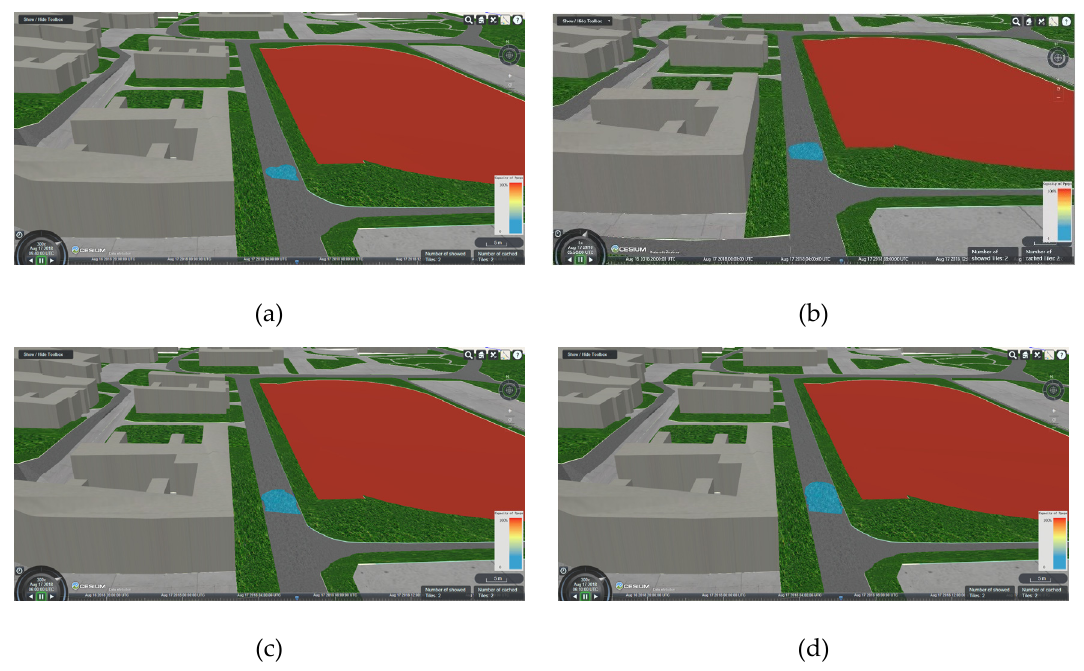
Figure 20 . The 3D dynamic flooding in steps of ten minutes. (a) to (d) are the flooded areas of the road Figure 20. The 3D dynamic flooding in steps of ten minutes. ( a – d ) are the flooded areas of the road every 10 minutes between 05:40 and 06:10 on August 17, 2018. every 10 min between 05:40 and 06:10 on 17 August